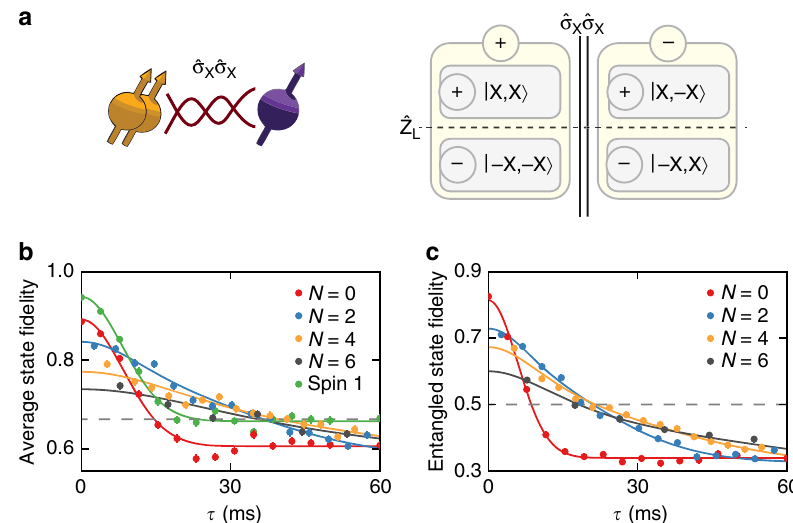
Figure 3 | Storing a logical quantum bit by repeated two-spin projections. ( a ) Schematic representation: the four-dimensional state-space of two 13 C spins (spin 1 and 2) is divided into two subspaces by repetitively projecting ^ O ¼ ^ s x ^ s x through entanglement with the ancilla spin. We define a logical quantum bit with logical operator ^ Z L ¼ ^ s x ^ I (dashed line) and associate ^ s x in ^ Z L with the spin with the longest coherence time (spin 1). ( b ) Storing a logical quantum bit. The average logical state fidelity for the six logical input states, for example, ð 1 þh ^ Z L iÞ = 2 for |0 i L , as a function of time and for a varying number of projections N . To compare the results to the best possible decay for a single nuclear spin, we compare to the individual decay of spin 1 and ffiffiffiffiffiffiffiffiffiffiffiffiffiffiffiffiffiffiffiffiffiffiffiffiffiffiffi q eliminate potential systematic detunings by measuring (instead of ^ s x or ^ s y ). The dashed horizontal line is the classical limit of 2/3 ^ s x h i 2 þ ^ s y (cid:11) (cid:12) 2 (ref. 37). ( c ) Preserving two-spin entangled states. The two-spin state fidelity, averaged over the four entangled input states, indicates that general two-spin states in the subspace are preserved. Above the dashed horizontal line ( F ¼ 0.5) the state is entangled. For N ¼ 2, 4 and 6 projections, entanglement is preserved longer than without projections. Solid lines are fits to equation (3) with the initial amplitude A , an offset and the effective dephasing time T (cid:3) as 2 ; eff free parameters. Error bars are 1 s.d. and are smaller than the